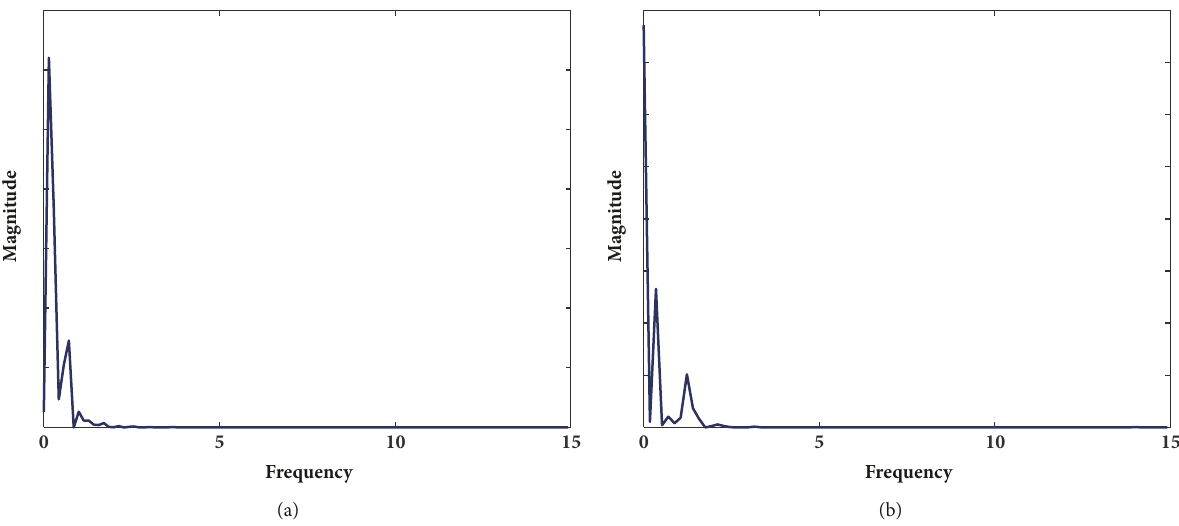
Figure 3: Frequency (in Hz) analysis of (a) illumination change and (b) vibration under automotive driving